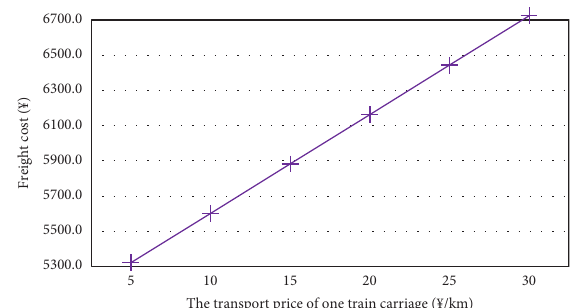
Figure 13: Schematic diagram of freight cost and operating cost of per train